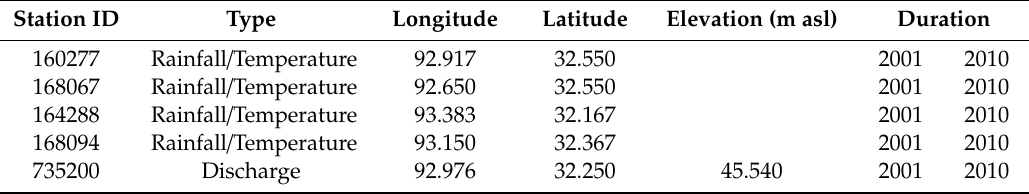
Table 1. Information of hydrological, meteorological, and other data used in the